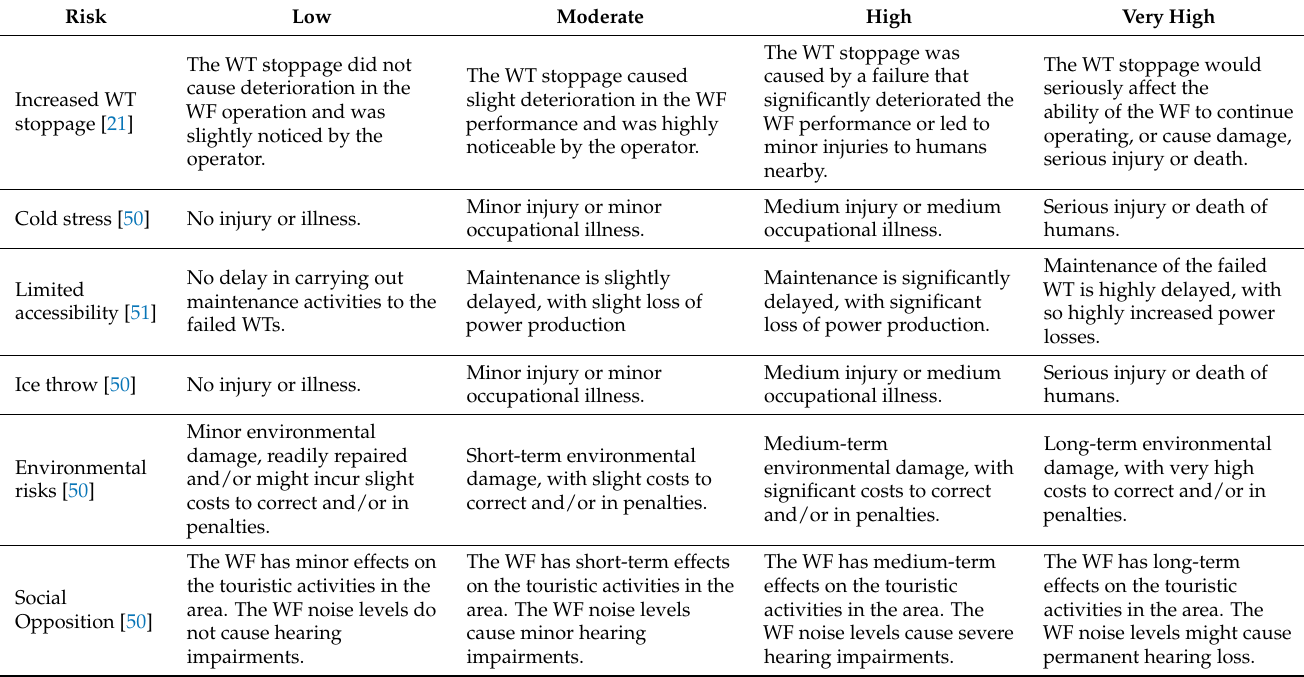
Table 5. Criteria for the consequences of risks experienced by WFs in CCRs.